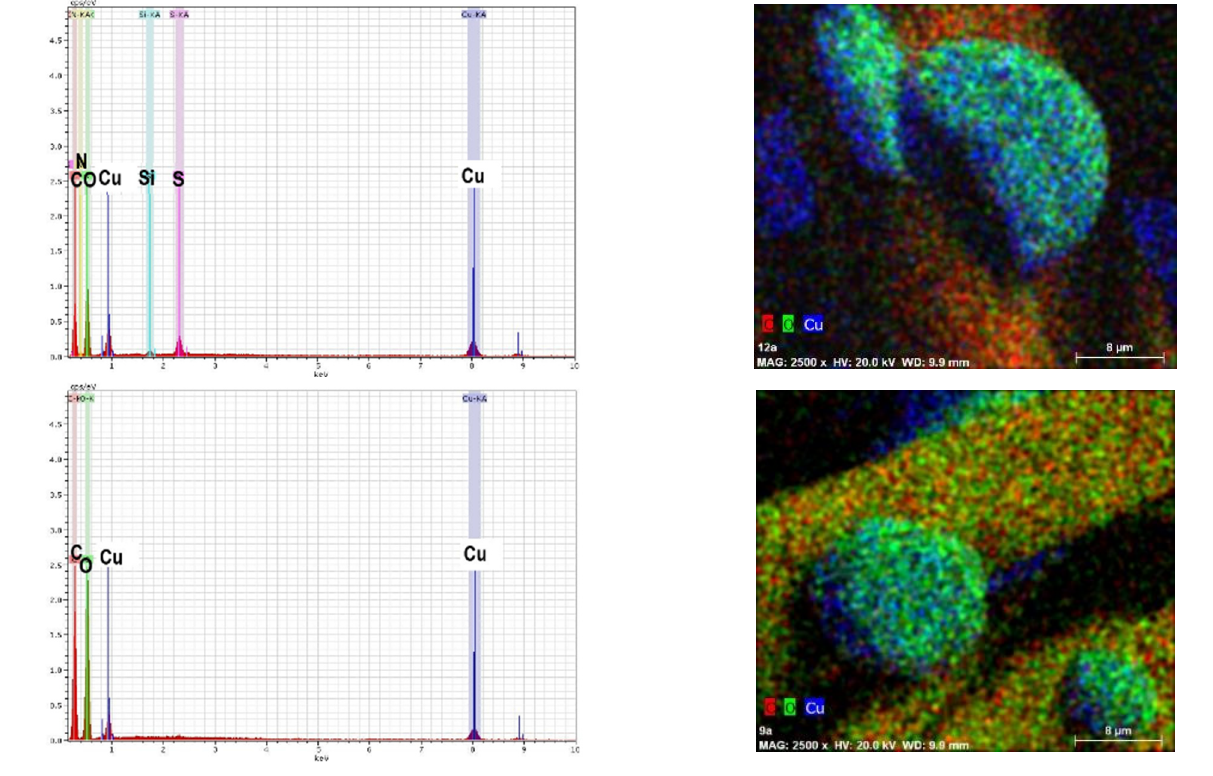
Figure 4. EDX spectra of the modified samples W ( top ) and C ( bottom ) and their chemical element maps (magnification 2,500 × ).